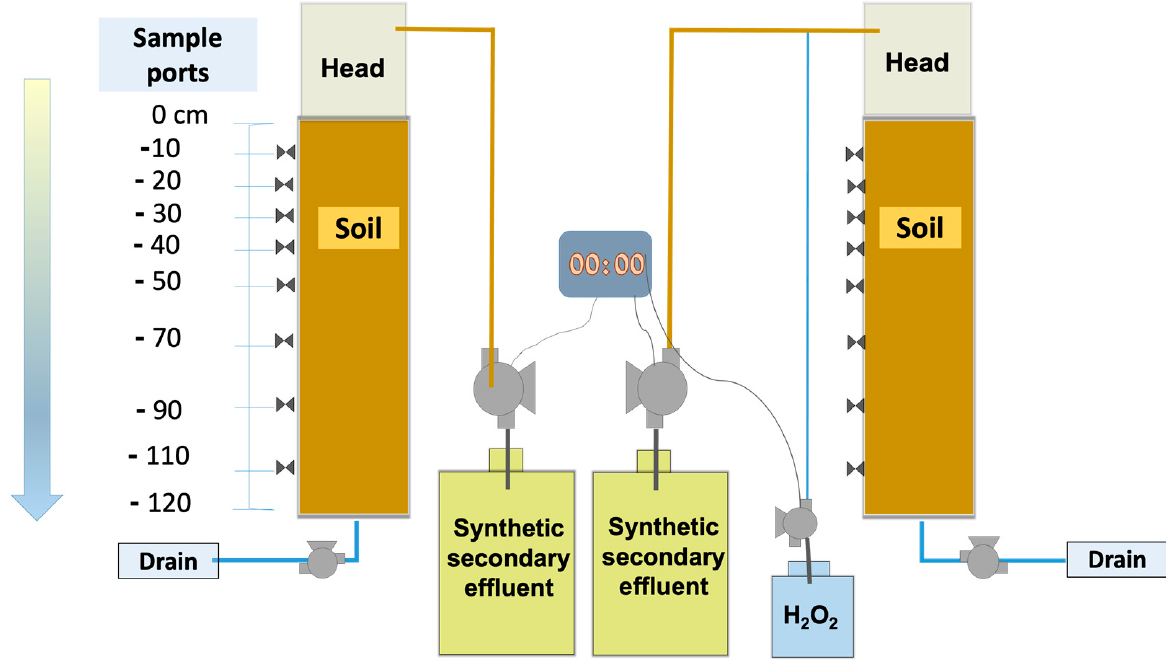
Figure 1. Soil column setup. Control column (RC; ( left )) and H 2 O 2 column (HPC; ( right )) fed with synthetic secondary effluent (tanks in the middle) and H 2 O 2 (tank on the right). All pumps were controlled by a timer.